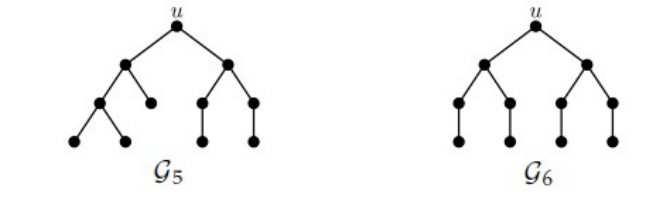
Figure 3. Trees G 5 and G 6